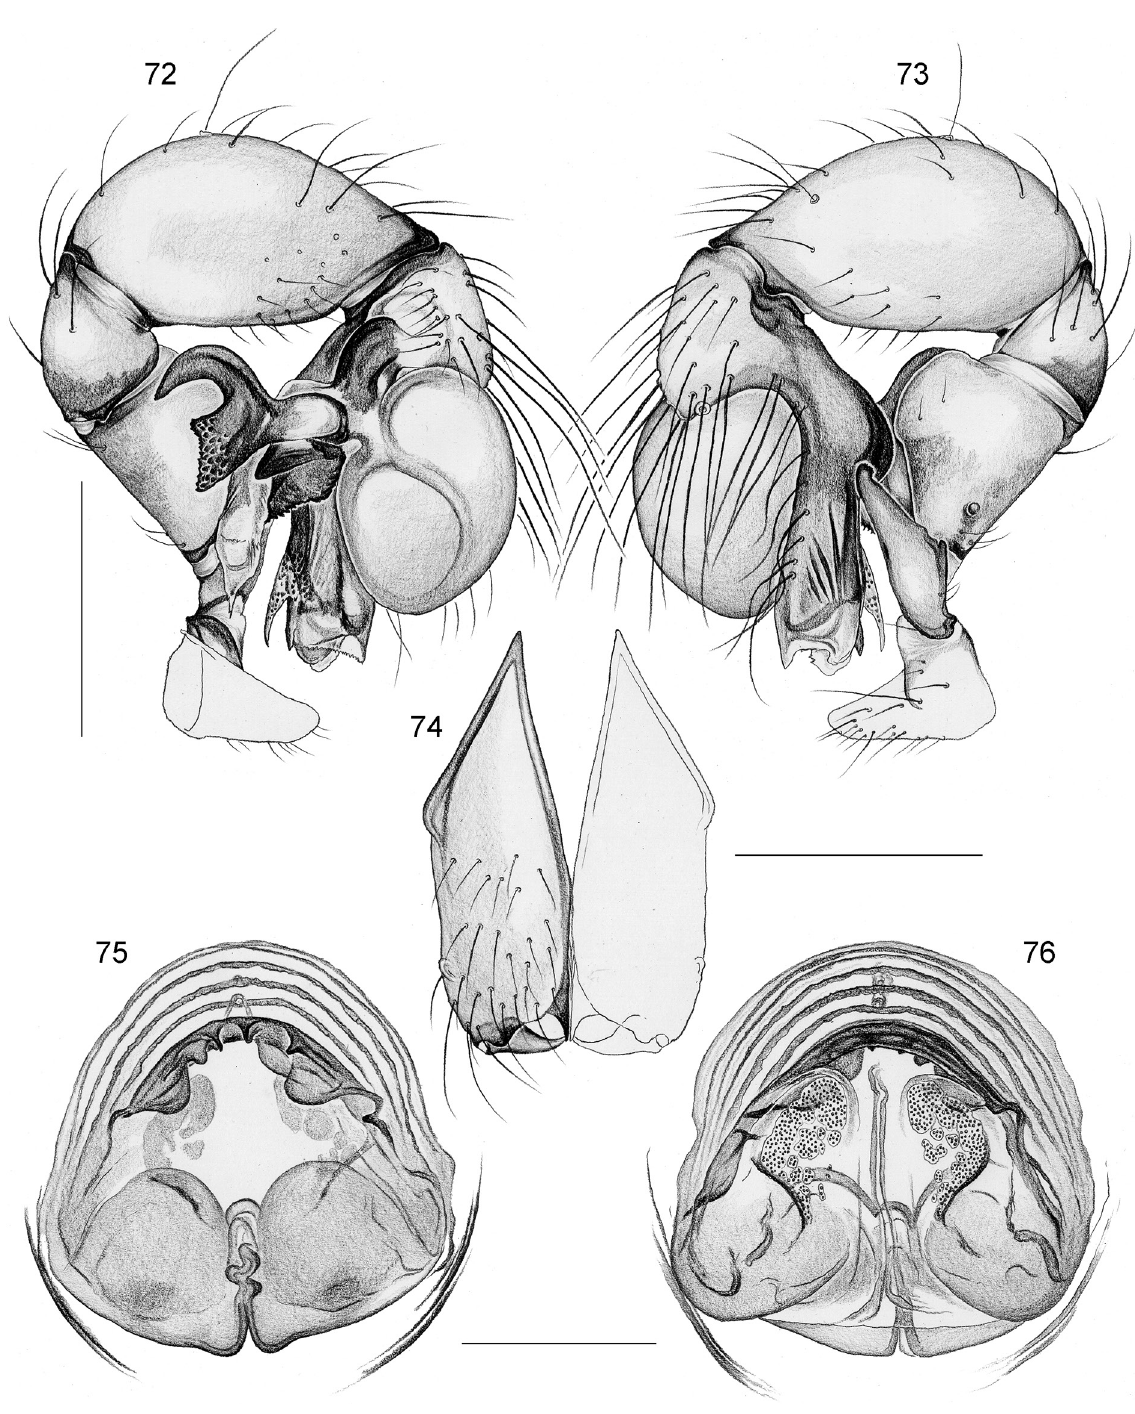
Figs 72-76. Leptopholcus kintampo sp. nov. 72-73 . Left ♂ palp, prolateral and retrolateral views. 74 . ♂ chelicerae, frontal view. 75-76 . Cleared ♀ genitalia, ventral and dorsal views. Scale lines: 72-73 = 0.5 mm; 74-76 = 0.3